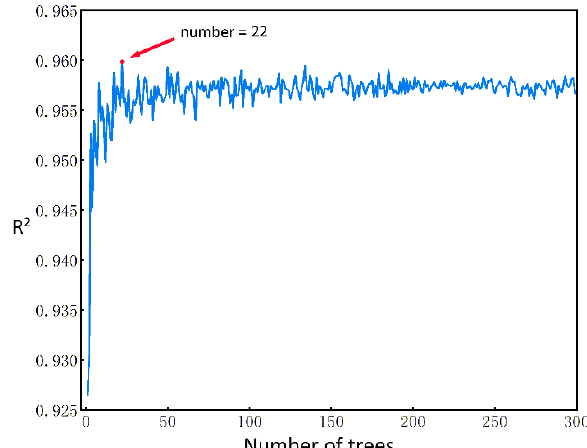
Figure 9. Debugging of the number of decision trees.